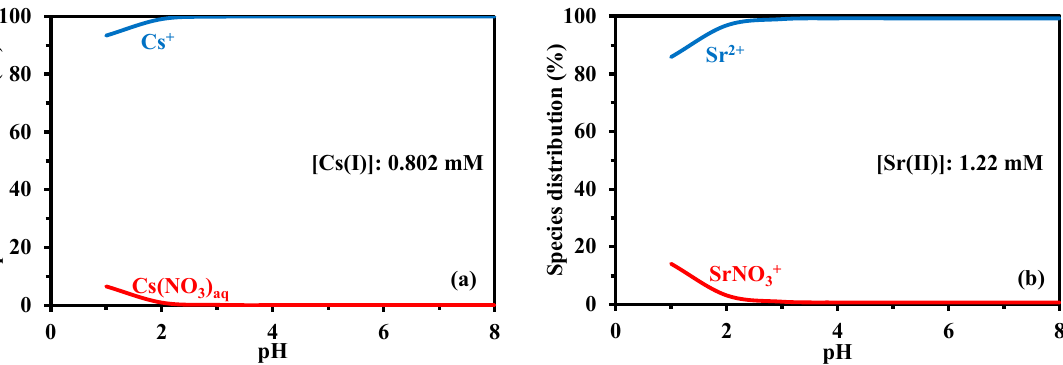
Figure A9. Speciation diagrams of Cs(I) ( a ) and Sr(II) ( b ) (under the experimental conditions selected for the study of pH effect, calculations using Visual MINTEQ software [76]).